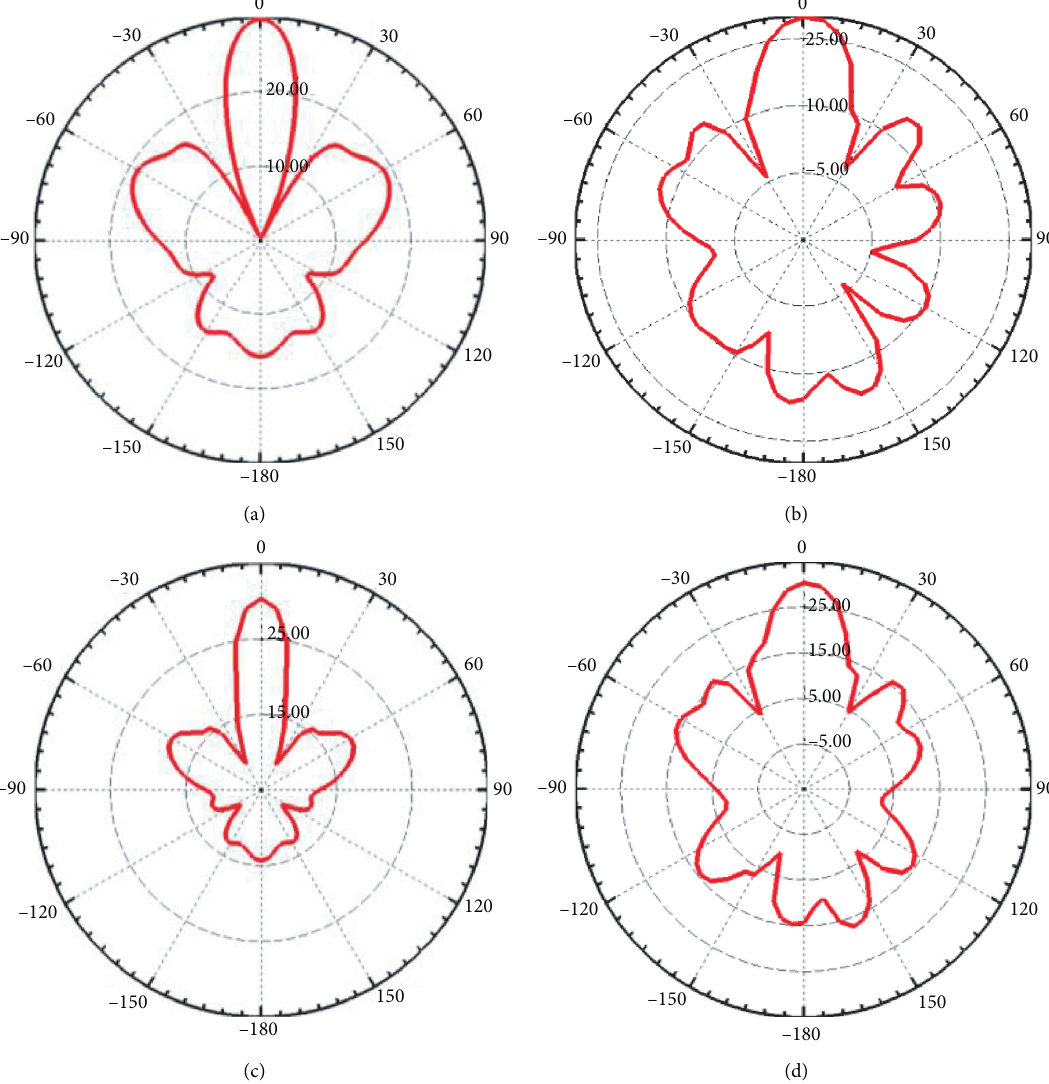
Figure 8: Simulated radiation patterns in HFSS software at 14GHz for (a) E-plane and (b) H-plane and at 14.2GHz for (c) E-plane and (d)